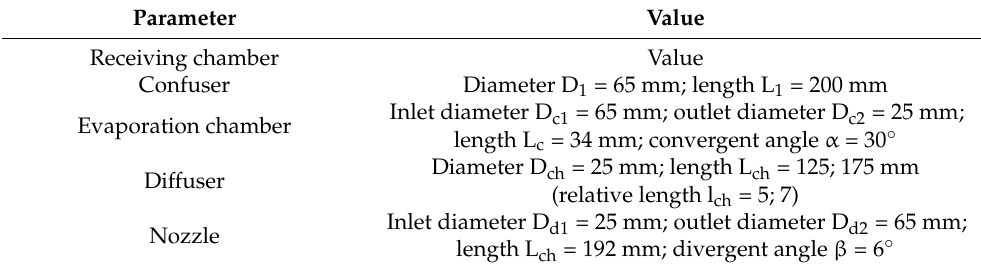
Figure 4. Experimental thermopressor. Table 1. Geometrical characteristics of the experimental